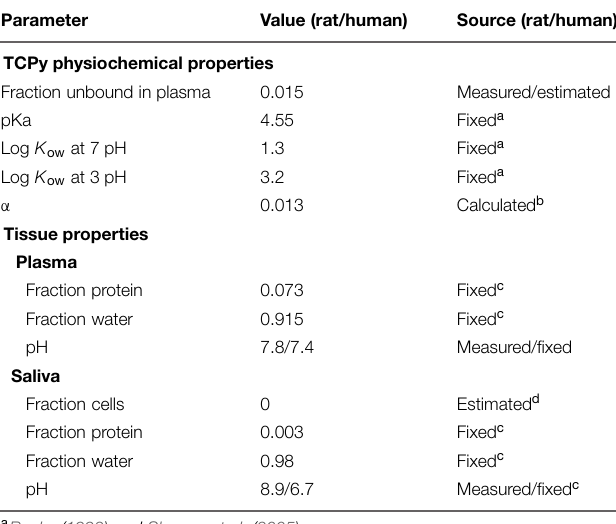
TABLE 1 | Input parameters for a modified algorithm for calculating the saliva:blood trichloropyridinol ( TCPy ) partitioning coefficient (based upon Schmitt,